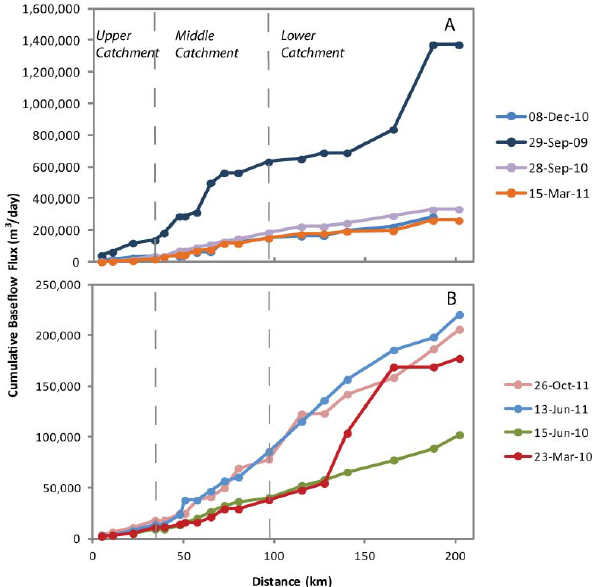
Fig. 8. Cumulative baseflow estimated from 222 Rn activities, based on high k values, in flow conditions of 4894 to 18520MLday (A) and of 995 to 2606MLday (B) . High cumulative baseflow usually occurs in high flow conditions.